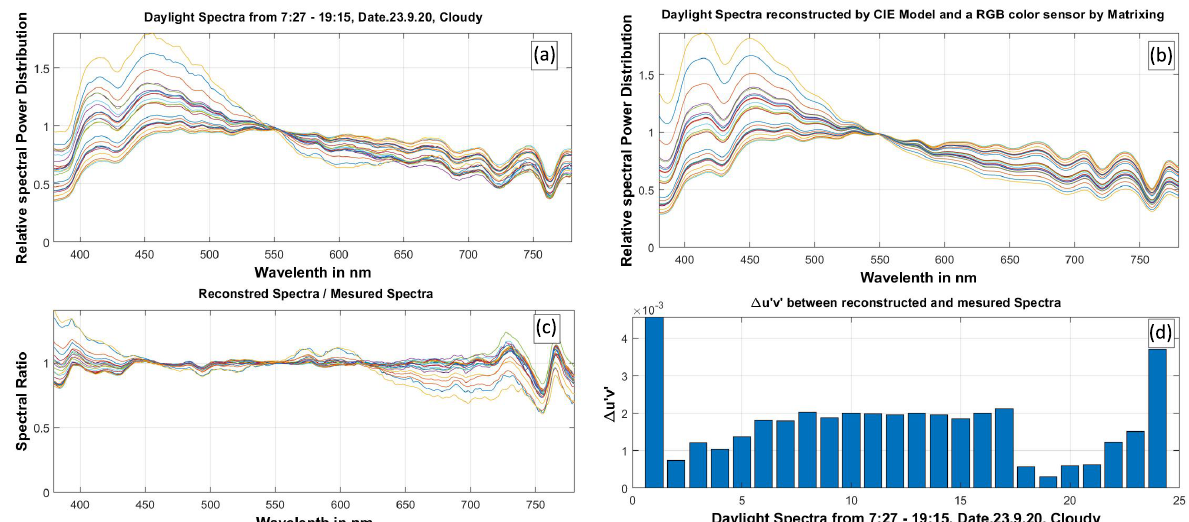
Figure 12. Validation set of measured daylight spectra and visualization of the CIE model per- formance. ( a ) Daylight spectra as measured in Darmstadt, Hessen, Germany (GPS coordinates 49°51 (cid:48) 20.772 (cid:48)(cid:48) N, 8°39 (cid:48) 12.528 (cid:48)(cid:48) E) on 23 September 2020 from sunrise (7:14 a.m.) to sunset (7:21 p.m.). ( b ) Reconstructed daylight spectra from color sensor readouts by applying the CIE daylight model. ( c ) Spectral ratios between the original measurements and the reconstructed spectra. ( d ) Color differences ∆ u (cid:48) v (cid:48) between measured and reconstructed spectra.